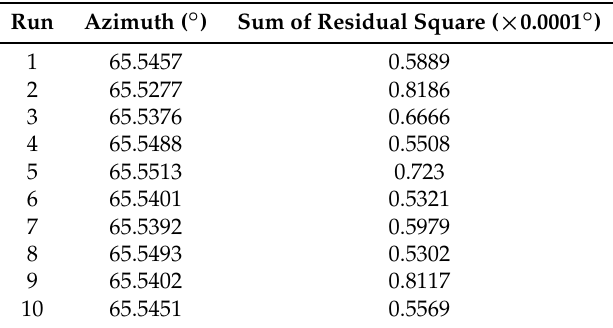
Table 4. Azimuth measurement results with n = 180.